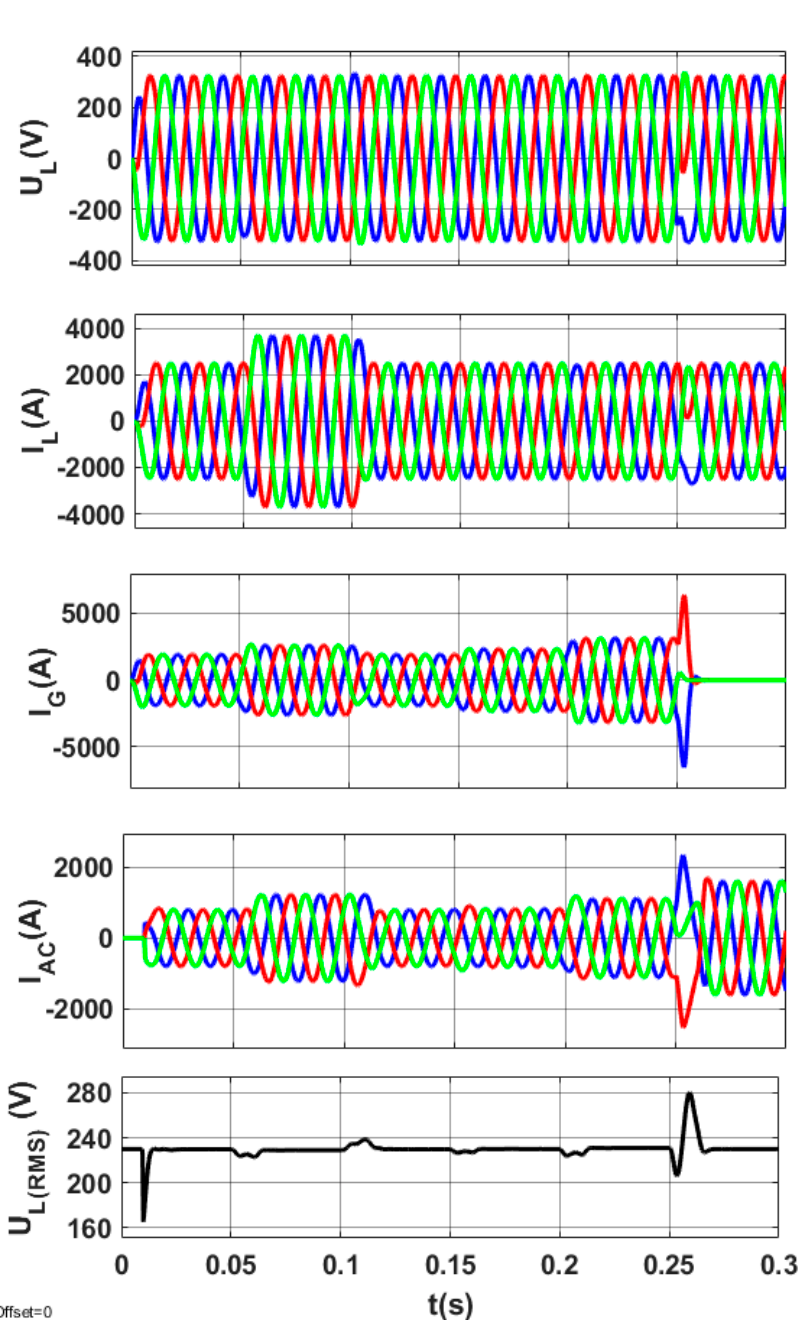
Figure 15. Electromagnetic processes in the system with AC